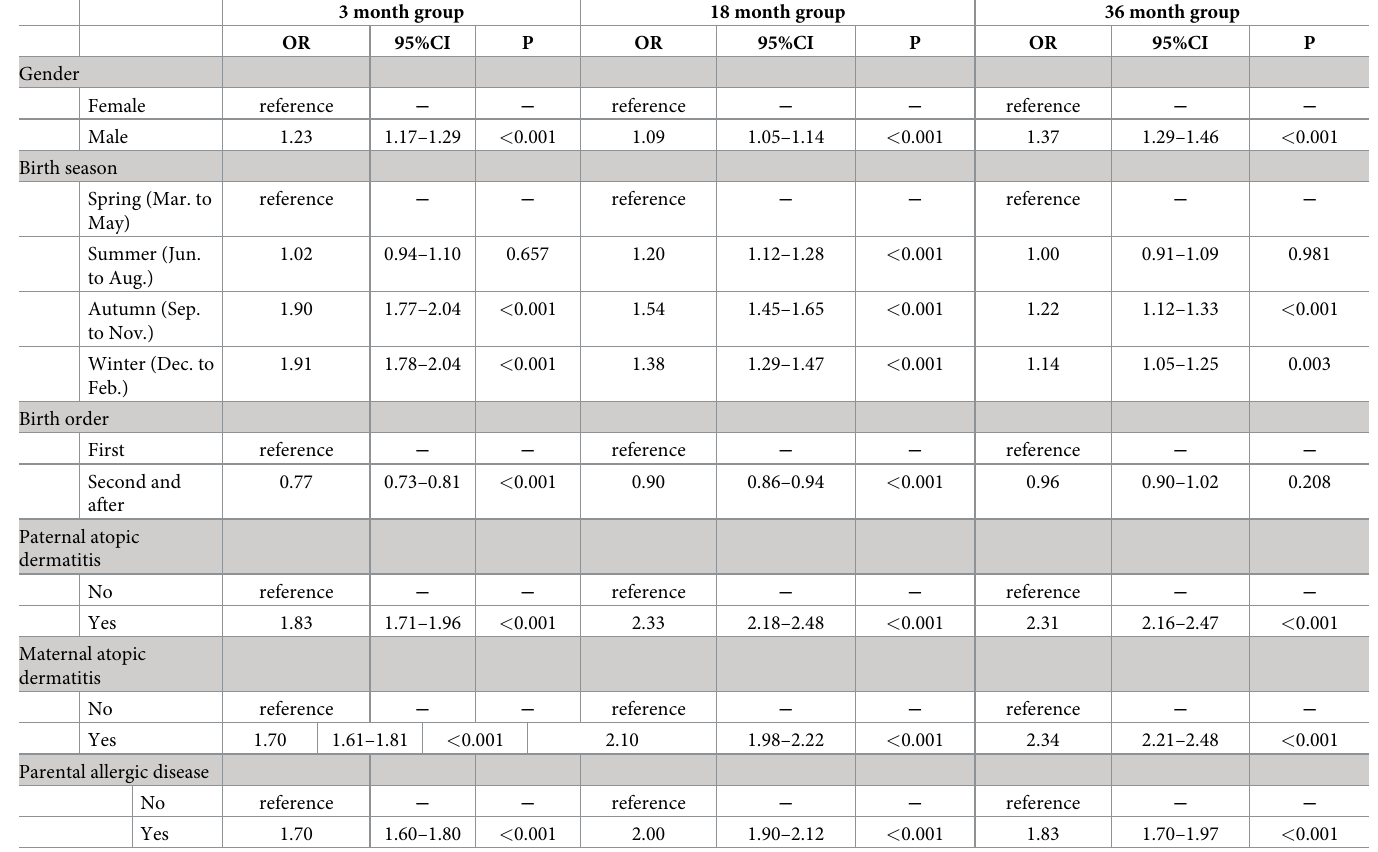
Table 3. Univariate analysis between eczema and covariates in three age groups.